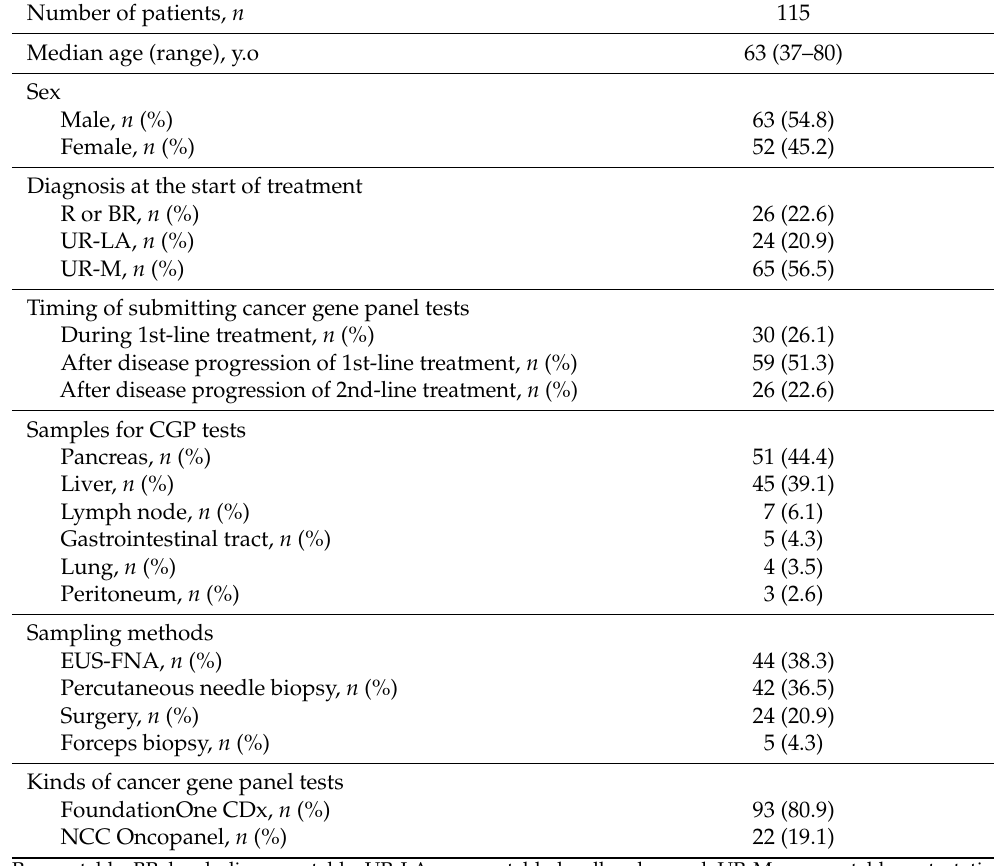
Table 1. Patient characteristics of patients with incurable pancreatic cancer who underwent compre- hensive genomic profiling (CGP)